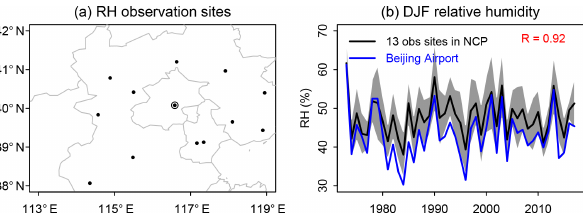
Figure 2. Representativeness of relative humidity (RH) observed at Beijing Airport and used in this work for correlation to PM 2 . 5 . (a) Location of Beijing Airport and the 12 surrounding sites of the NOAA Global Summary Of the Day (GSOD) network in the North China Plain (NCP). (b) Time series of DJF 1973–2017 mean rela- tive humidity (RH) at the Beijing Airport site and for the ensemble of the 13 NCP sites. Shaded area denotes 1 standard deviation. The correlation coefficient ( R ) of RH at Beijing Airport with the North China Plain (NCP) average is